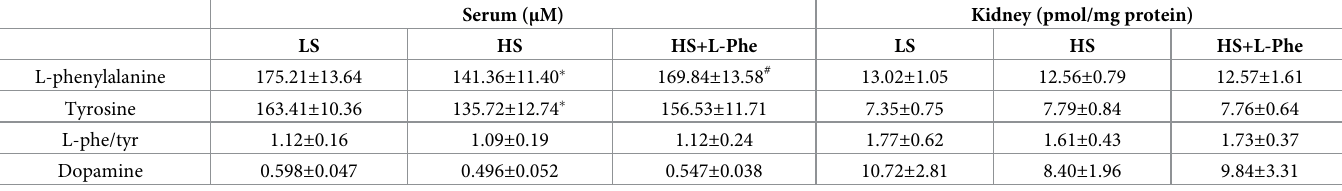
Table 2. Effects of L-phenylalanine supplementation on levels of L-phenylalanine, tyrosine, L-phe/try, and dopamine in both serum and the kidney of SS